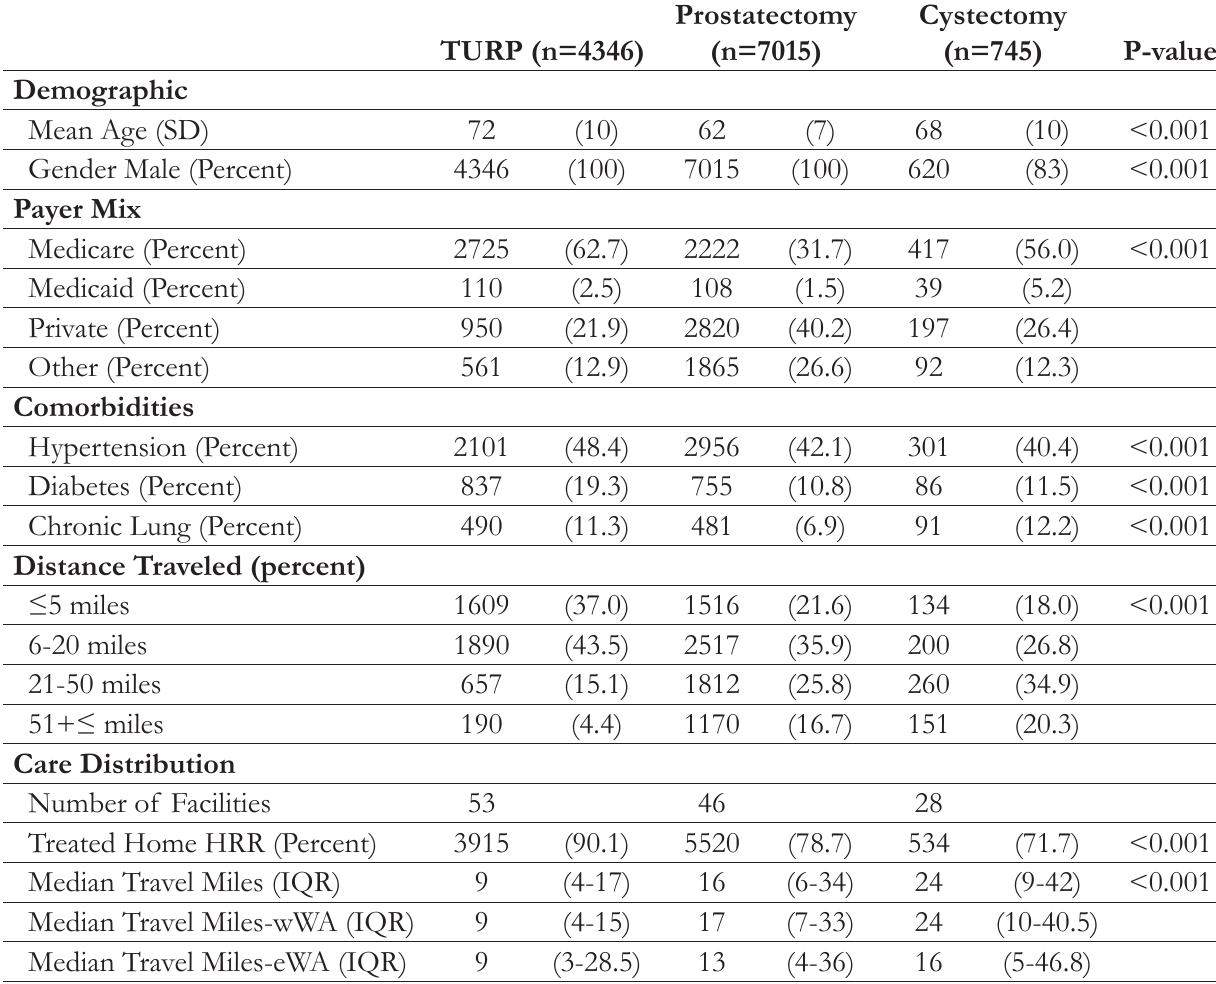
Table 1. Characteristics of Hospitalized Patients Select Surgical Urologic Procedures Discharged 2009-2013 (N=12 106) TURP